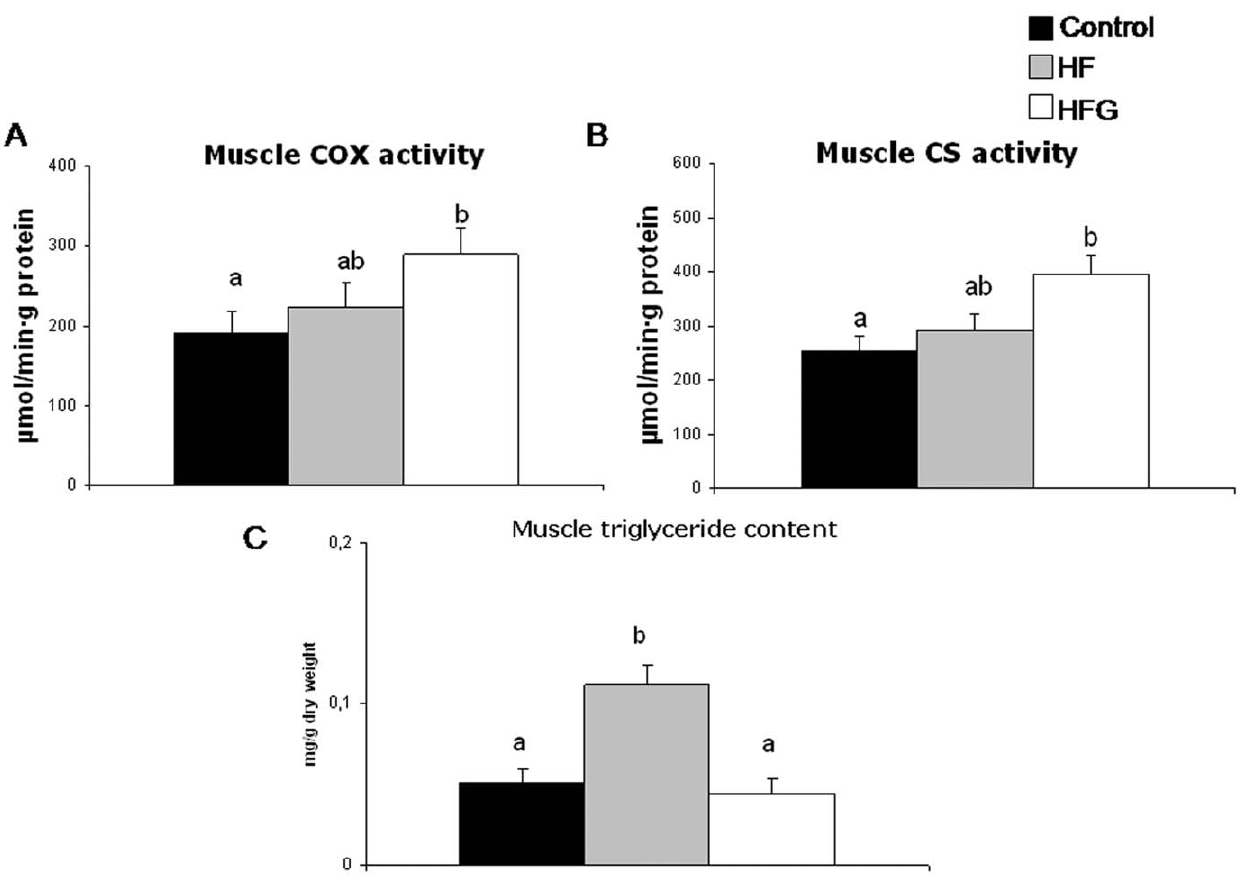
Figure 2. Acylated ghrelin with HF diet enhance gastrocnemius muscle mitochondrial enzyme activities. Effects of one-month high-fat feedingwithout(HF) orwith(HFG) 4-dayacylatedghrelintreatmentongastrocnemiusmuscleactivitiesofmitochondrial cytochromecoxidase(COX)(a)and citrate synthase (CS) (b) and on muscle triglyceride content (c). Different letters denote statistically significant differences (P , 0.05 ANOVA and post-hoc test).